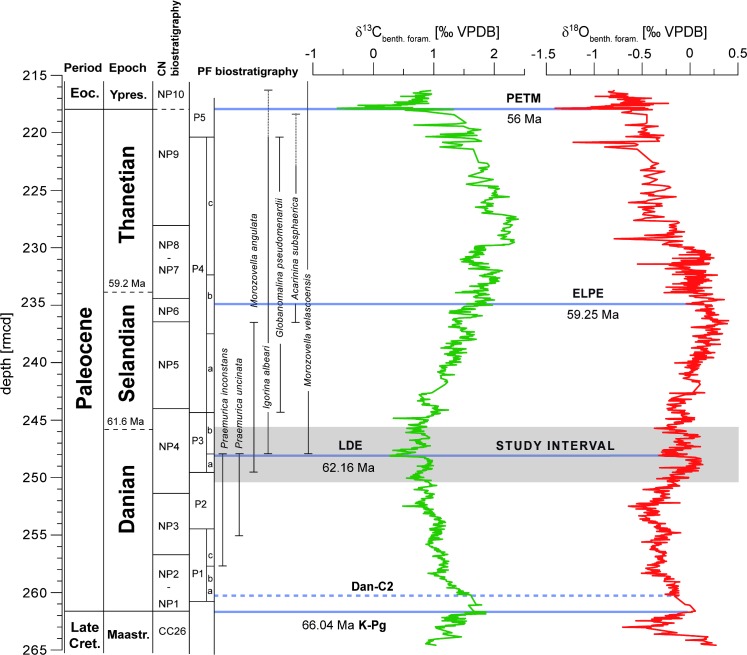
Stratigraphy, δ13C and δ18O measurements of benthic and planktic foraminifera on ODP Sites 1209:δ13C (green) and δ18O (red) in a long-term benthic Nuttallides truempyi record (plotted against rmcd [18]). Period, epoch, calcareous nannofossil, age and planktic foraminiferal biostratigraphy are from [18, 26], isotope data are adopted from [18]. Absolute ages given are based on [GTS 2012].